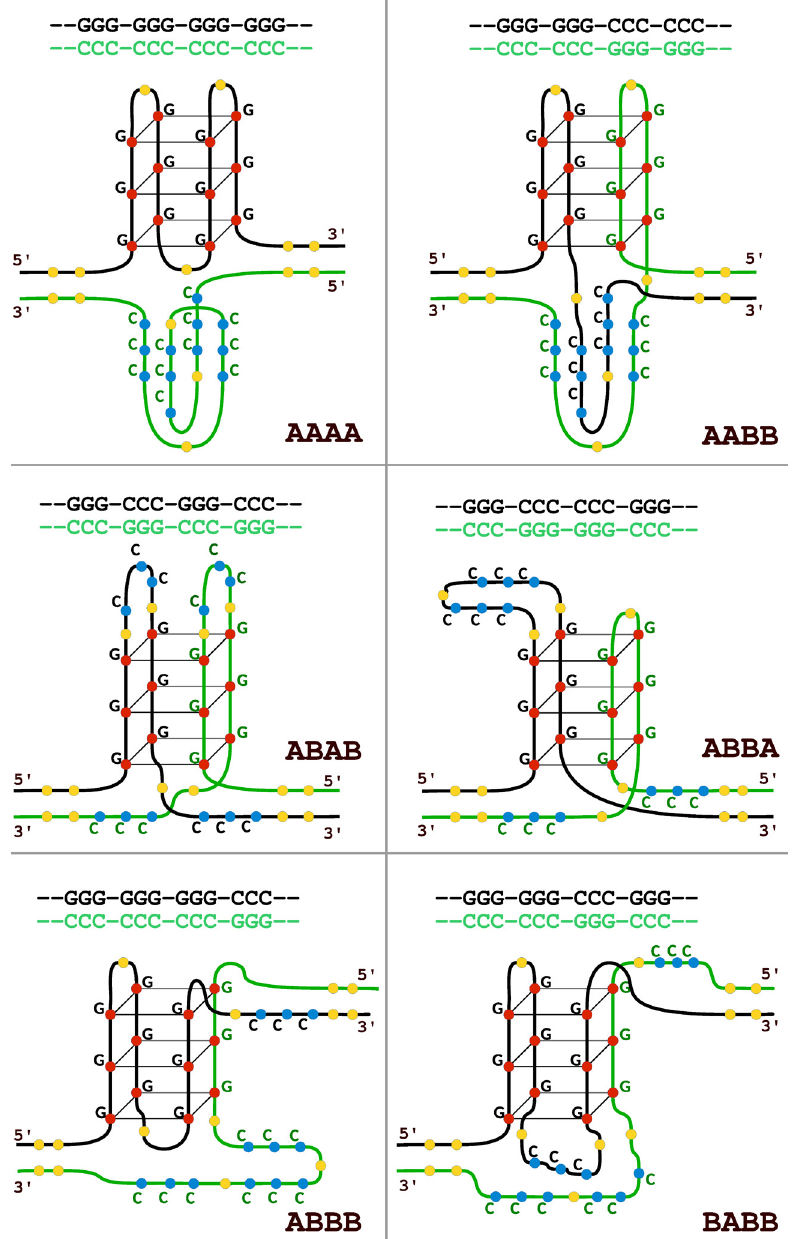
Fig 1. Examples of topology classes of G-quadruplex structures within genomic DNA. Examples of topological configurations of intrastrand and interstrand quadruplexes are shown schematically. For pairs of topology types that differ only by strand from which the sequence is derived (e.g. ABAB and BABA) only one is shown. Black, green — the Watson and Crick strands. Red: guanines, blue: cytosines, yellow: loops of up to seven nucleotides of any type. AAAA — the intrastrand topology, AABB, ABAB, ABBA, ABBB, BABB: interstrand configurations.